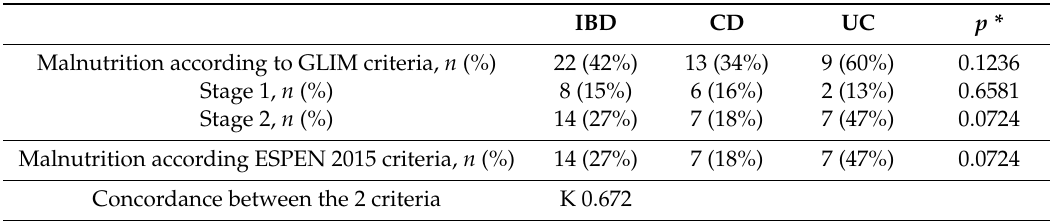
Table 5. Diagnosis of